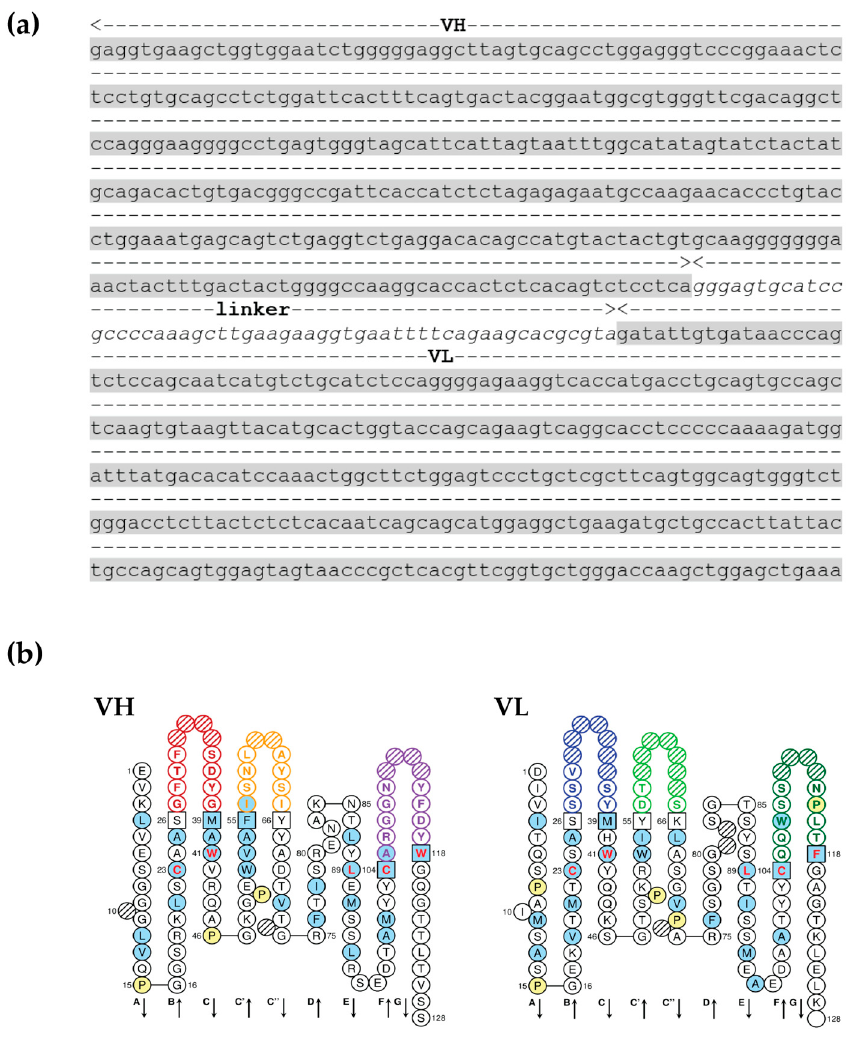
Figure 2. DNA sequence analysis of scFv anti - OvROPN1L - CL19 from recombinant pOPE101 plasmid . ( a ) Nucleotide sequence and immunoglobulin domain prediction of scFv anti - OvROPN1L - CL19 . The scFv anti - OvROPN1L - CL19 had heavy - chain ( VH ) and light - chain ( VL ) variable domains connected by a linker . ( b ) The 2D graphical representations of VH and VL protein domains of scFv anti - OvROPN1L - CL19 were drawn by IMGT / Collier - de - Perles.